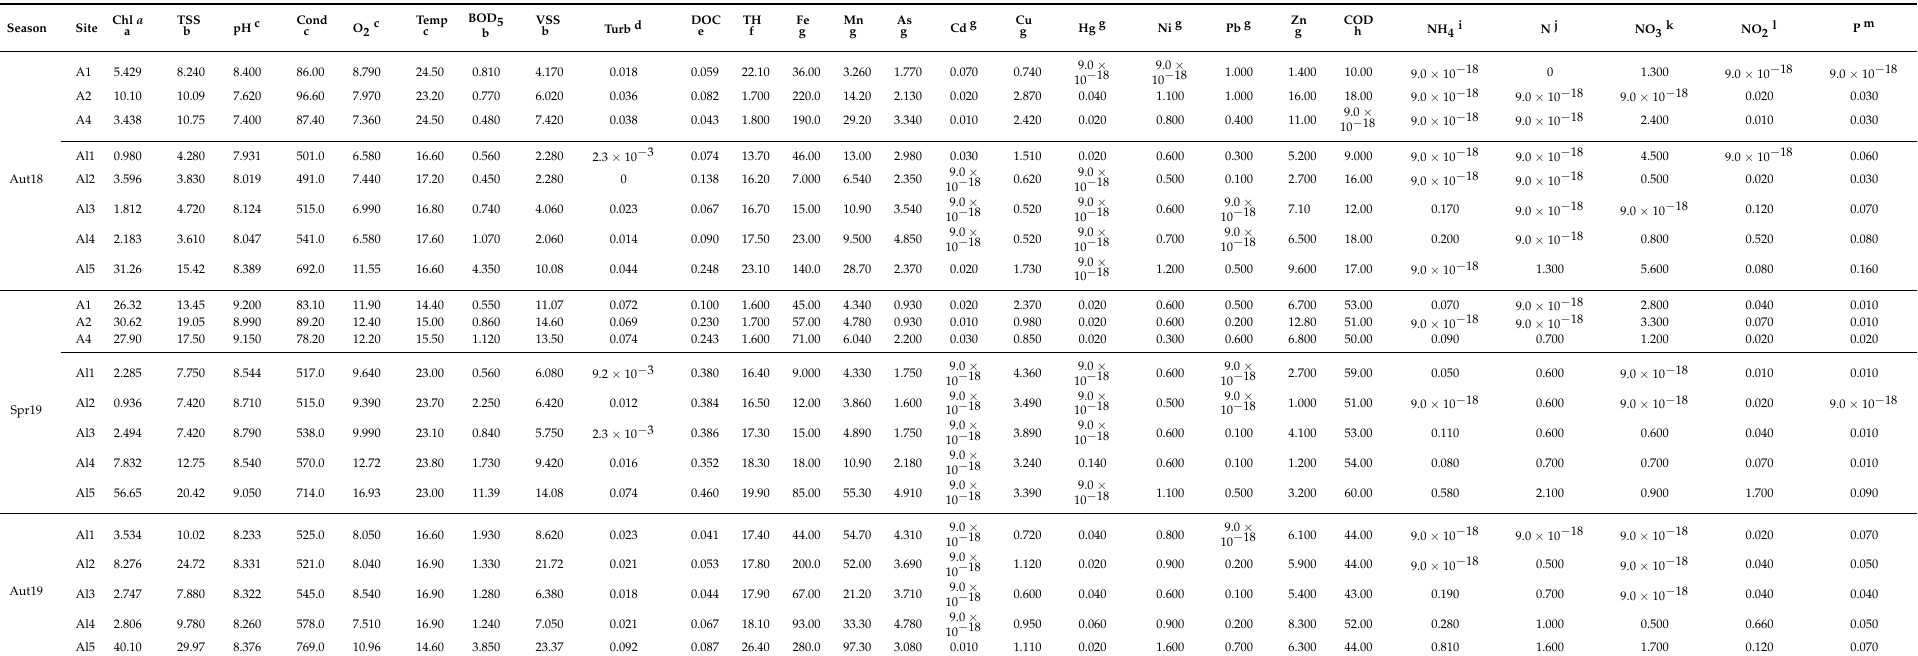
Table A2. In situ data concerning both reservoirs. O 2 is oxygen concentration (mg L − 1 ), Cond is conductivity ( µ S cm − 1 ), Temp is temperature ( ◦ C), TSS is total suspended solids measured in situ (mg L − 1 ), Chl a is the chlorophyll a measured in situ ( µ g L − 1 ), BOD 5 is the five-days biochemical oxygen demand (mg L − 1 ), VSS is the volatile suspended solids (mg L − 1 ), Turb is the turbidity (m), DOC is the dissolved organic carbon (m − 1 ), TH is the title hydrometric ( ◦ f), Fe is iron ( µ g L − 1 ), Mn is manganese ( µ g L − 1 ), As is arsenic ( µ g L − 1 ), Cd is cadmium ( µ g L − 1 ), Cu is copper ( µ g L − 1 ), Hg is mercury ( µ g L − 1 ), Ni is Nickel ( µ g L − 1 ), Pb is Lead ( µ g L − 1 ), Zn is Zinc ( µ g L − 1 ), COD is chemical oxygen demand (mg L − 1 ), NH 4 is